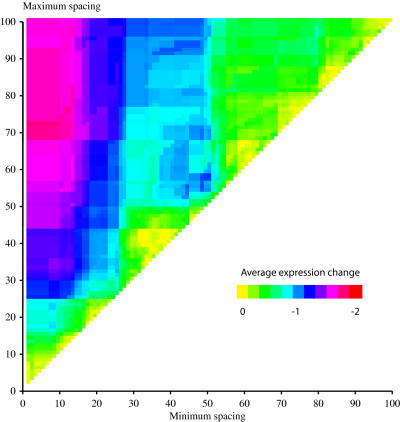
The optimal spacing range between Cbf1 and Met31 is 9 to 68 bases.We varied the minimum (X axis) and maximum (Y axis) distance that Cbf1 and Met31 could be from each other in our model, and calculated the average expression change within the corresponding top 30 hits, according to these ranges. We show here the average expression change for only those experiments that we expected to have a decreased expression (columns 10 to 13 in Fig. 6). The colors correspond to the key in lower portion of the plot.